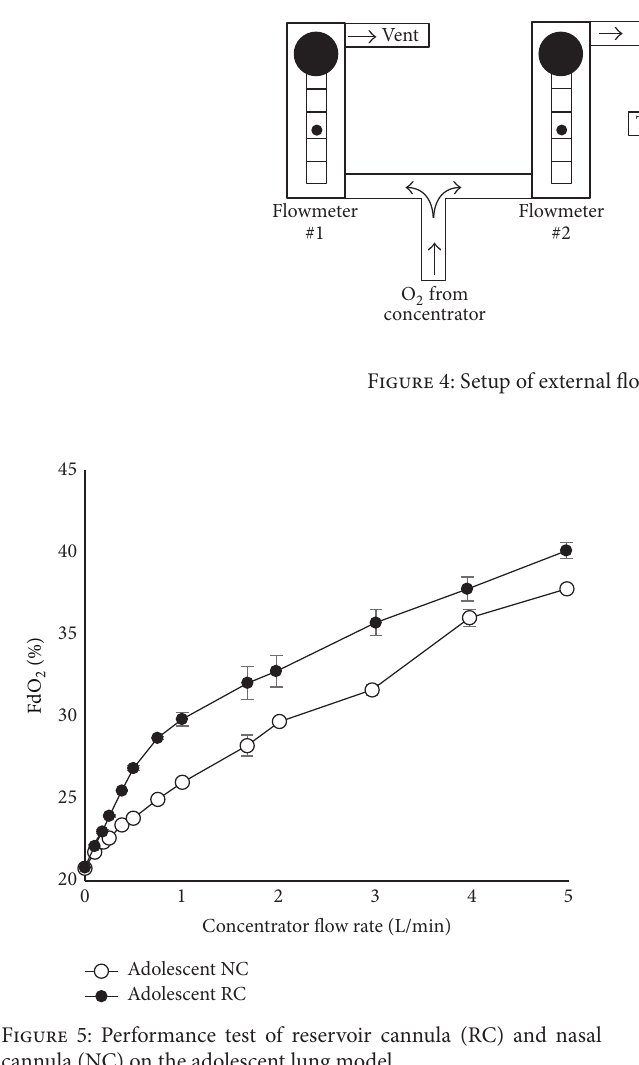
Figure 6: Performance test of RC and NC on the child lung